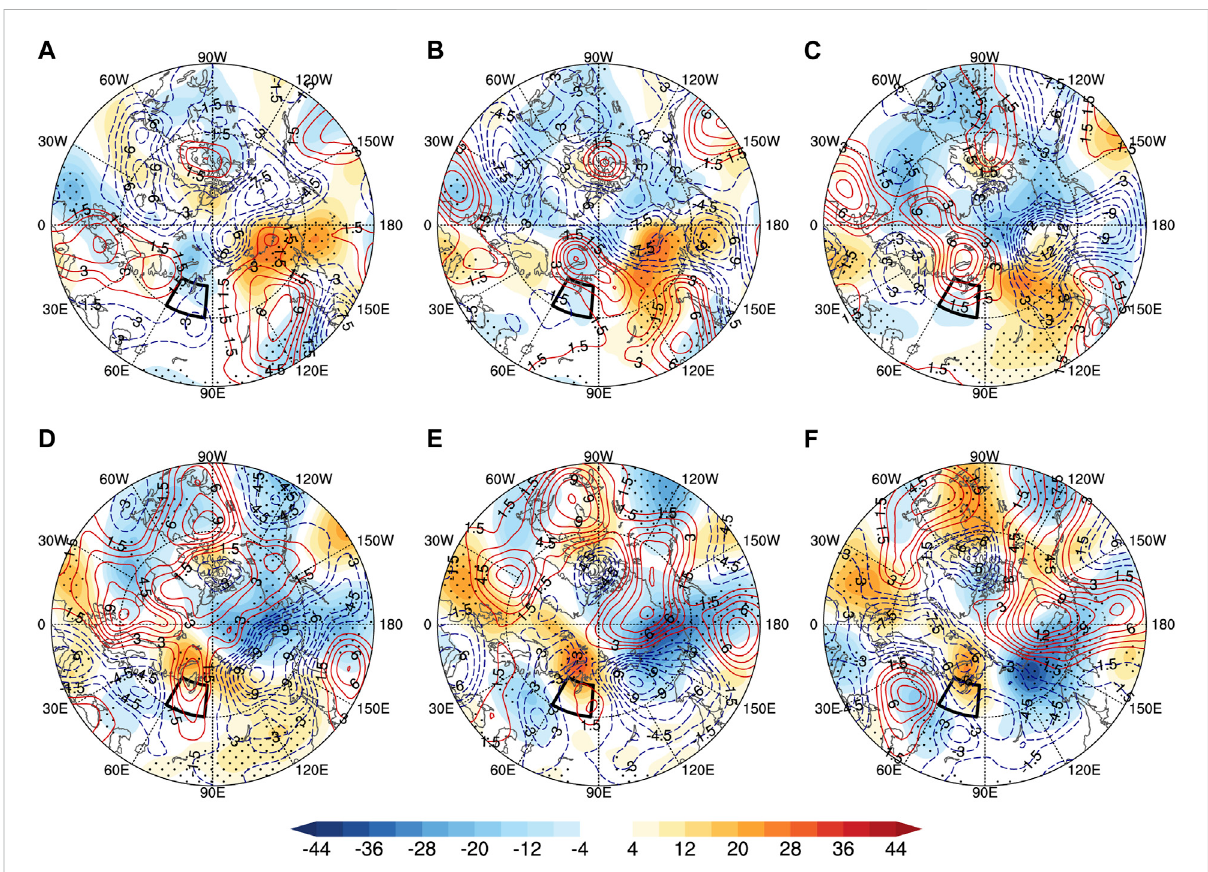
FIGURE 6 Quasi-biweekly-scale geopotential height anomaly (shading) and its tendency (contour) from day -10 to day 0 during the Meiyu onset period (A – F) (unit:gpm;blackbox: themid-high latitudekeyregion;thelatitudeoftheoutermost lineis40 ° N;dotsaretheareaswith statisticalsigni fi cance exceeding the 95% level).